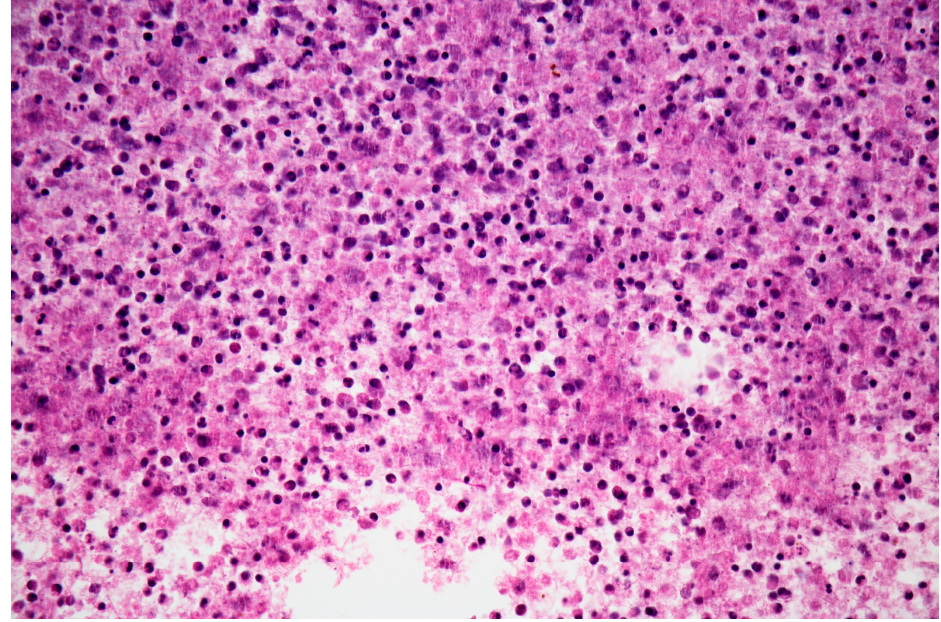
Figure 7. Hematoxylin-eosin stain 400×: necrotic material with lymphocytes, polymorphonuclear cells and cell debris.